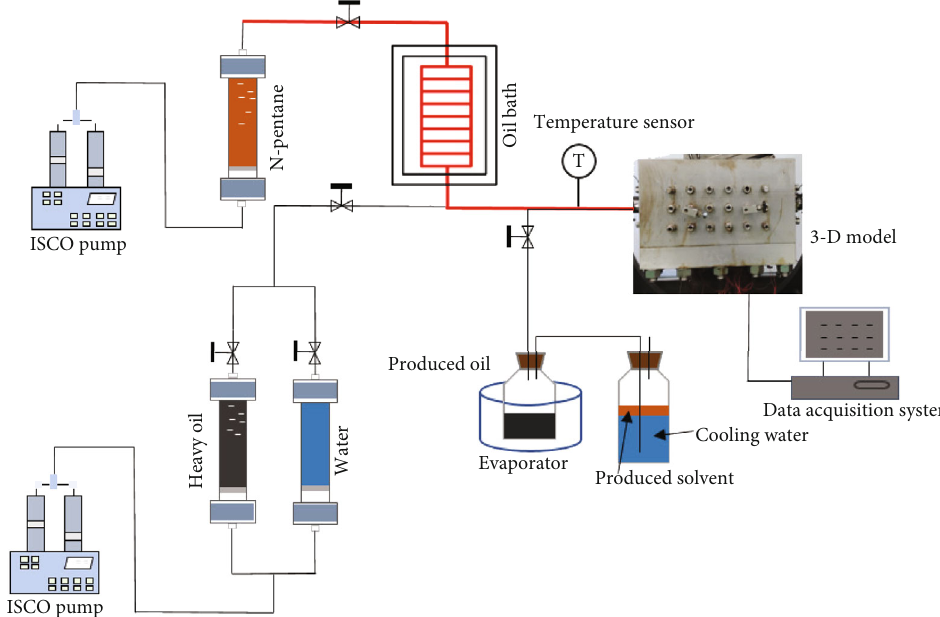
Figure 2: Flowchart of the 3D physical experiment of hot solvent mining oil sand